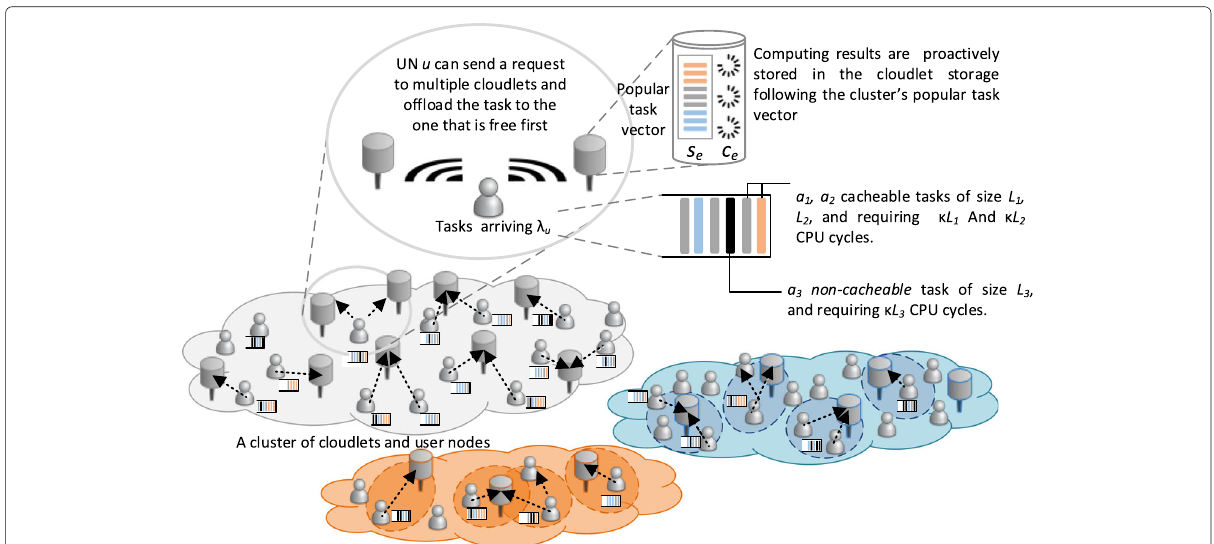
Fig. 1 Network illustration. An illustration of the clustered fog network model with cache-enabled